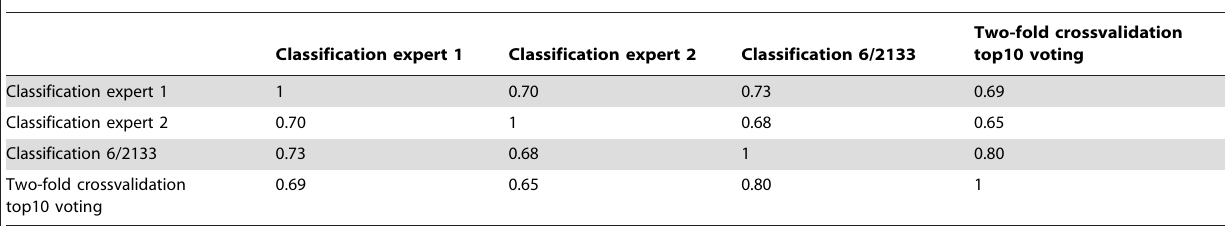
Table 2. Human and machine judgements on data set 1. a